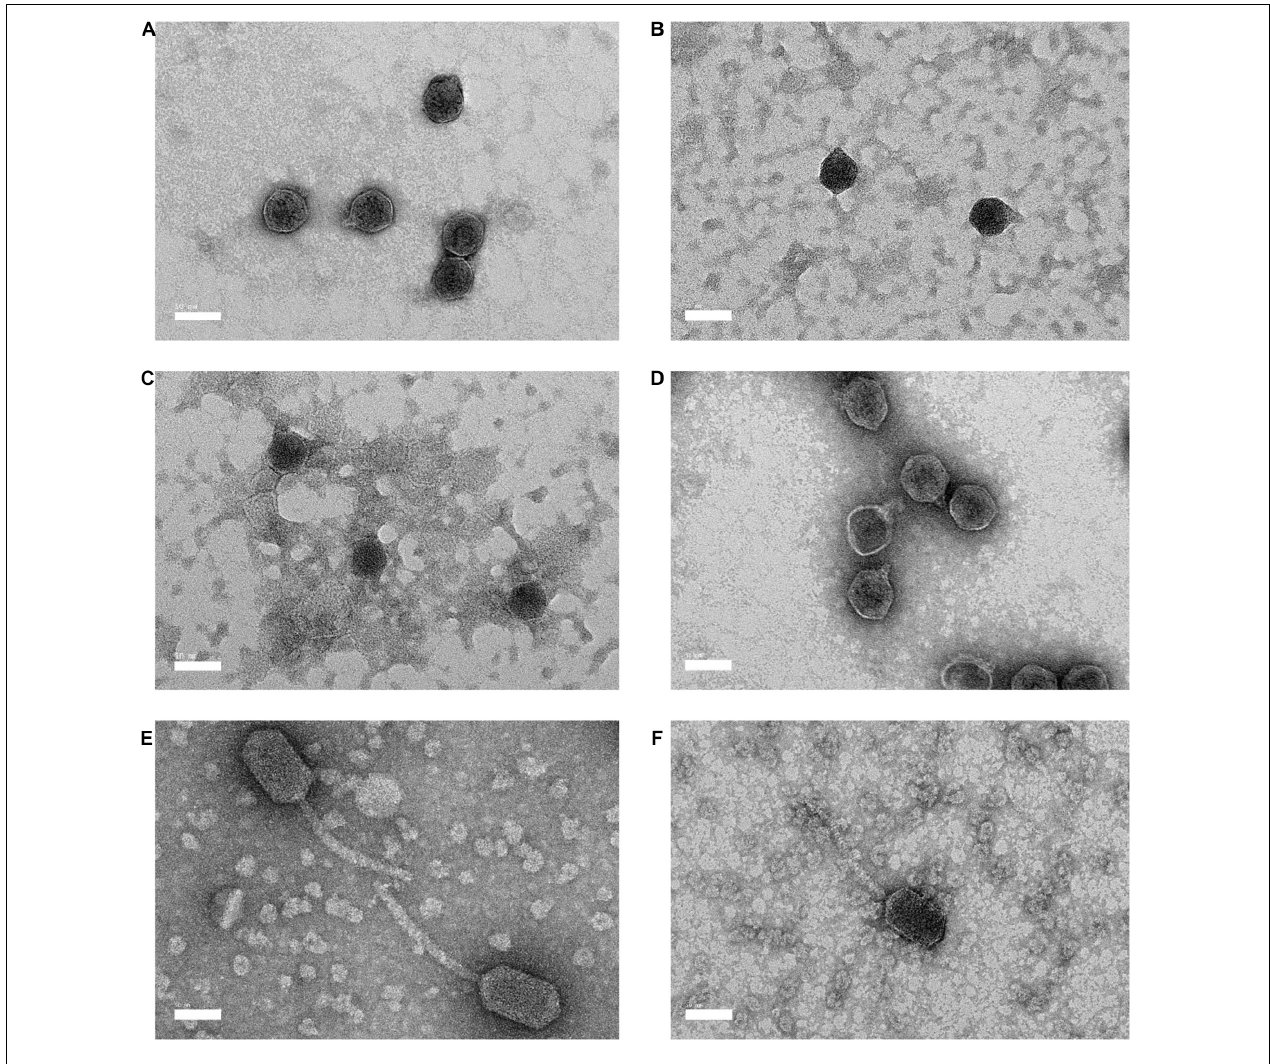
FIGURE 1 | Electron micrography of negative stained Vibrio parahaemolyticus bacteriophages and the bar represents 50 nm. (A) Vp33 (head diameter: 44.70 ± 2.30 nm; tail diameter: 9.22 ± 0.92 nm); (B) Vp22 (head diameter: 41.28 ± 1.83 nm; tail diameter: 8.72 ± 2.29 nm); (C) Vp21 (head diameter: 42.63 ± 2.07 nm; tail diameter: 9.86 ± 1.15 nm); (D) Vp02 (head diameter: 50.00 ± 3.21 nm; tail diameter: 12.44 ± 2.30 nm); (E) Vp08 (head diameter: 91.78 ± 4.11 nm × 49.54 ± 2.05 nm; tail diameter: 142.24 ± 13.47 nm) (F) Vp11 (head diameter: 79.00 ± 5.94 nm × 44.98 ± 1.60 nm; tail diameter: 133.79 ± 15.98